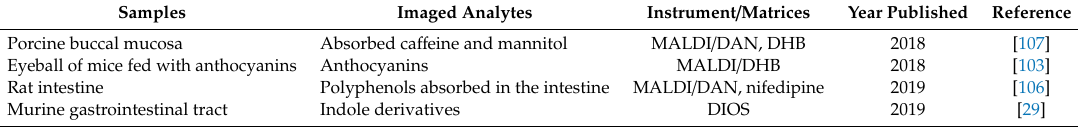
Table 4. Overview of the application of MSI for imaging of administered nutritional factors.